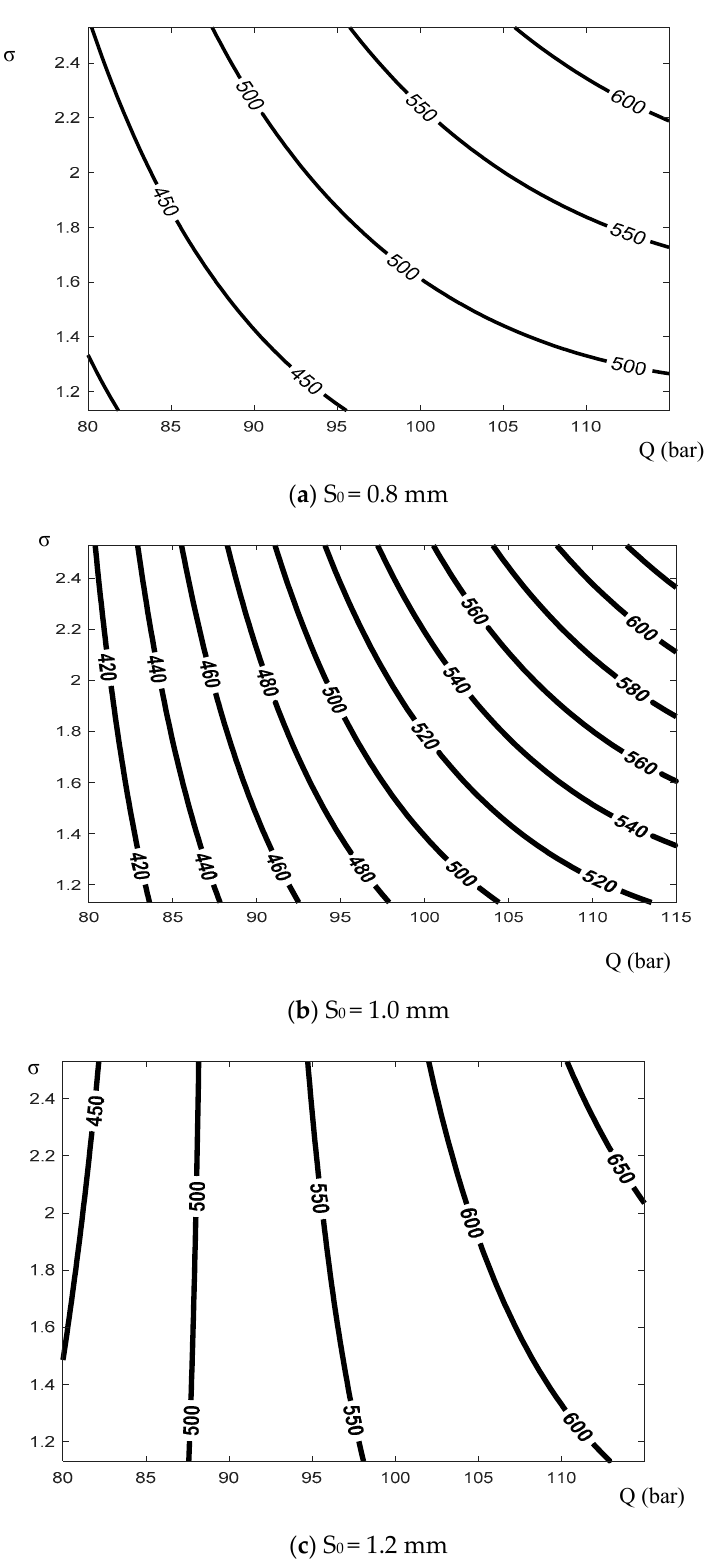
Figure 11. Dependence of the maximum forming pressure on the binder pressure and the ratio of stress.